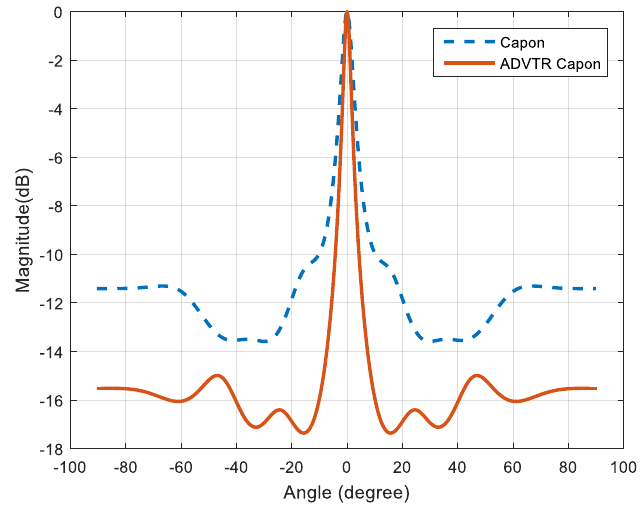
Figure 14. Capon estimator and ADVTR Capon estimator in the tank.